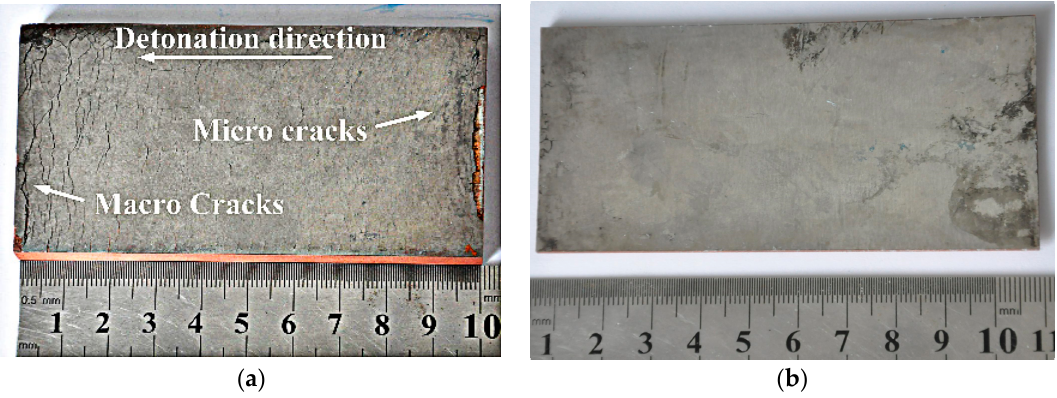
Figure 4. Photograph of recovered W–Cu plates: ( a ) 0.5 mm thick W (sample T-1); ( b ) 0.1 mm thick W (sample T-8).